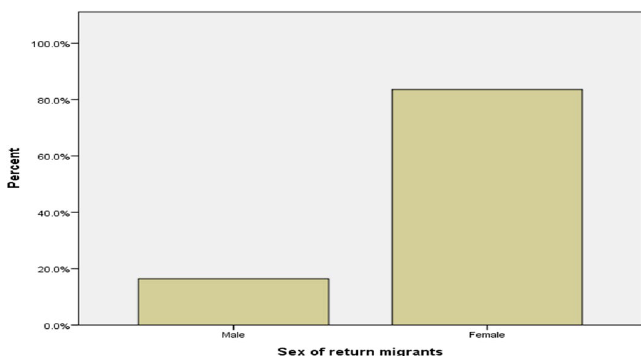
Fig. 1 Sex of return migrants. Source Field Survey Result,